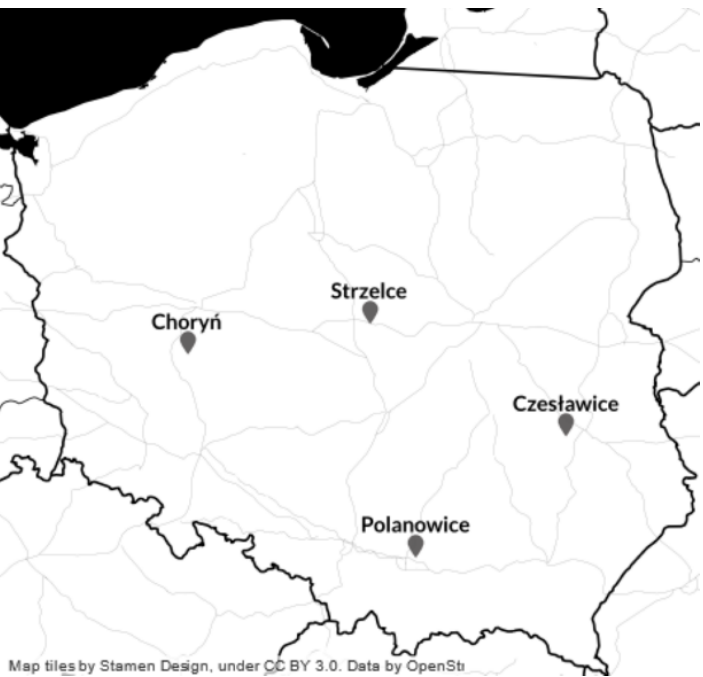
Figure 1. Geographic distribution of the locations from which the Bga isolates were collected.